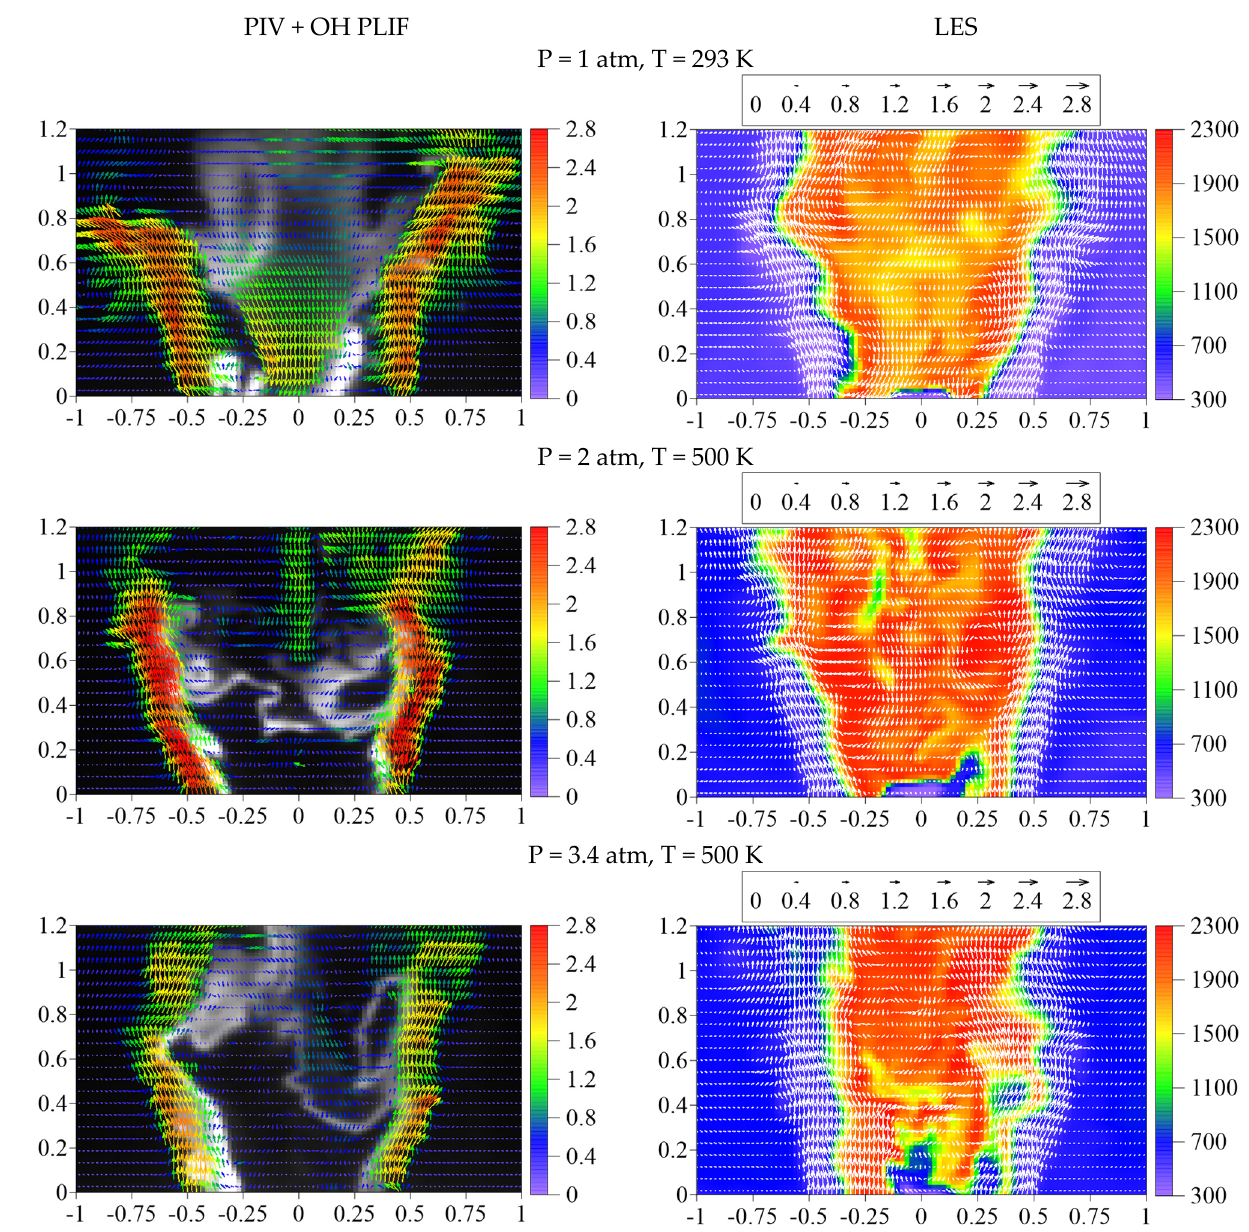
Figure 5. Instantaneous velocity field and OH arbitrary concentration ( left column) and simulated instantaneous and temperature field ( right column) depending on pressure and preheat tempera- ture.